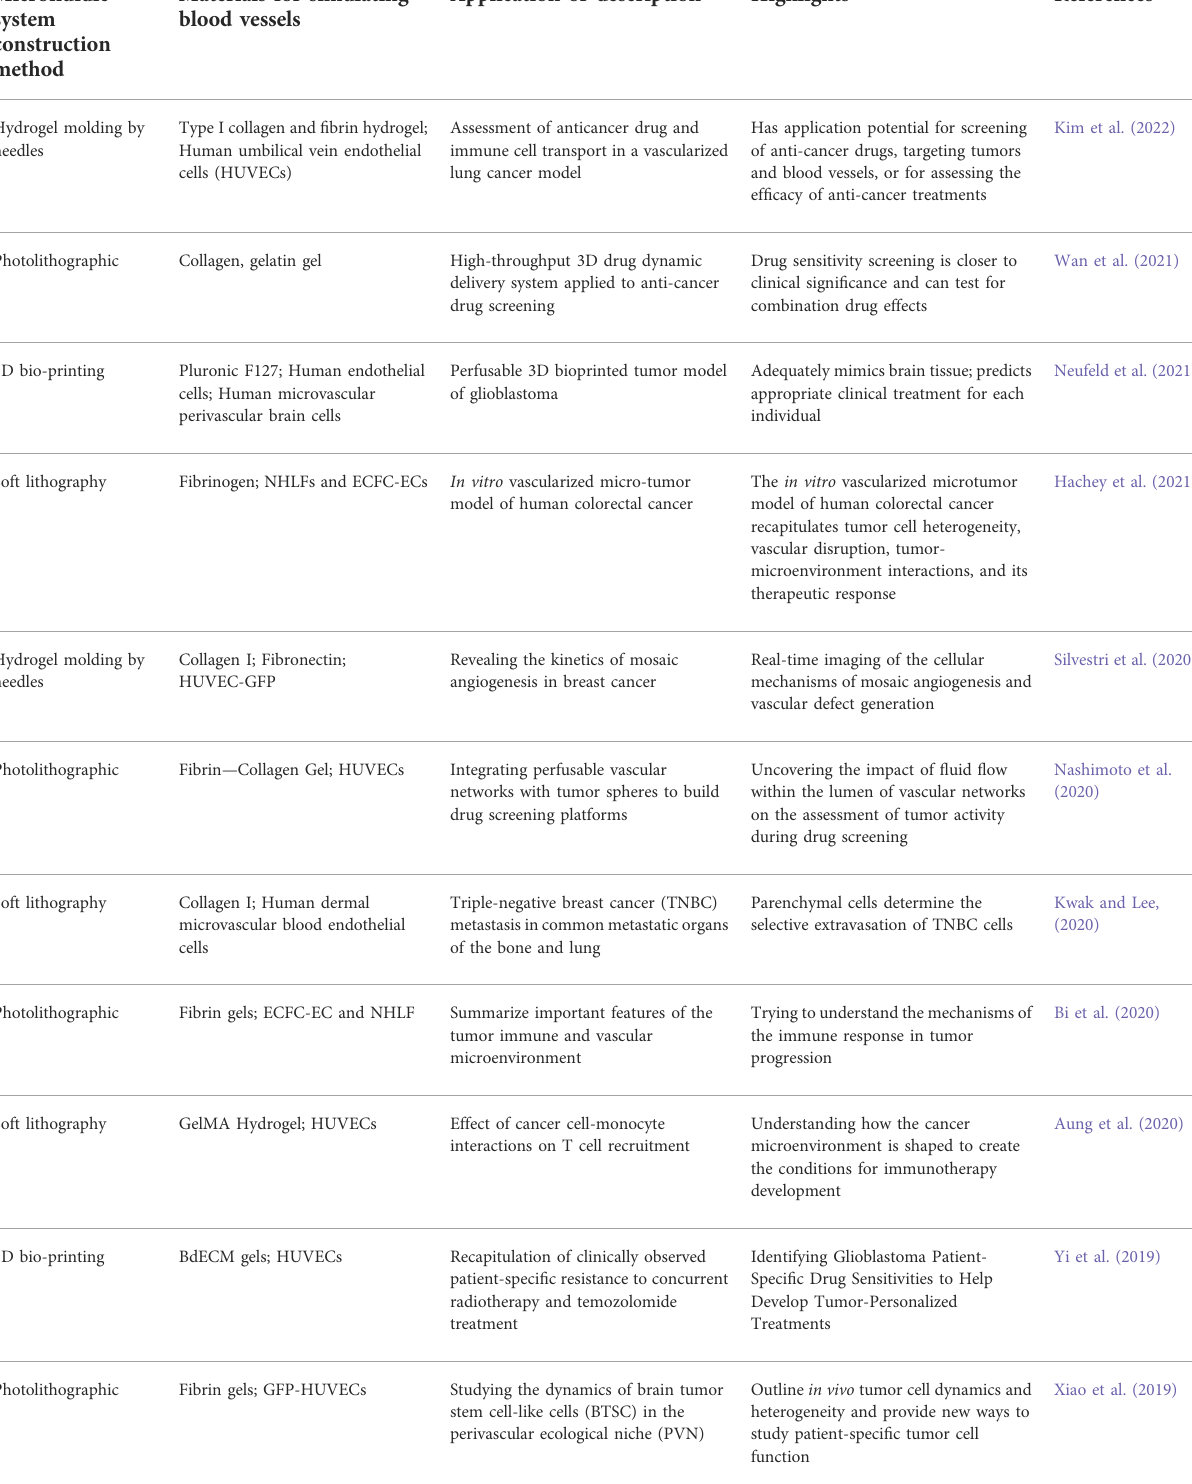
TABLE 1 Breakthroughs in tumor-on-a-chip technology for building vascularized cancer